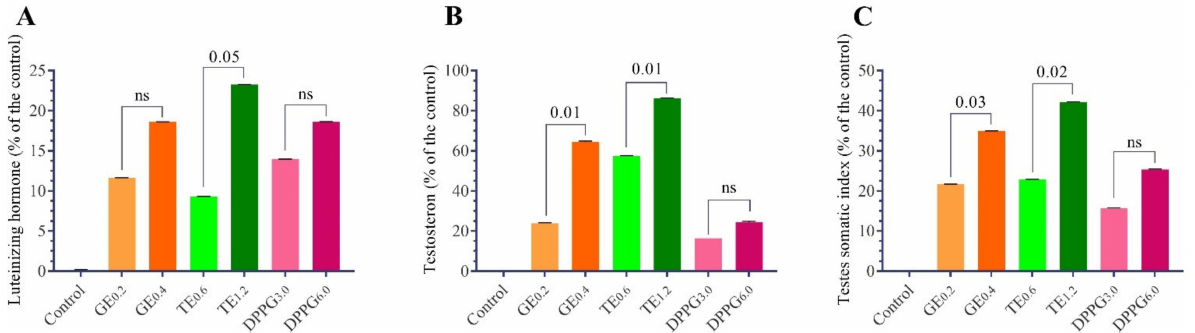
Figure 1. Effect of different antioxidants supplementation (g/kg diet) on changes of luteinizing hormone ( A ), testosterone levels ( B ) and testis somatic index ( C ) as a percent of the control of male Nile tilapia, O. niloticus . GE, ginseng extract; TT, Tribulus terrestris extract; DPPG, date palm pollen grains. (n = 15) ns: non significant, 0.05–0.001 the t -test significant levels of actual parameter